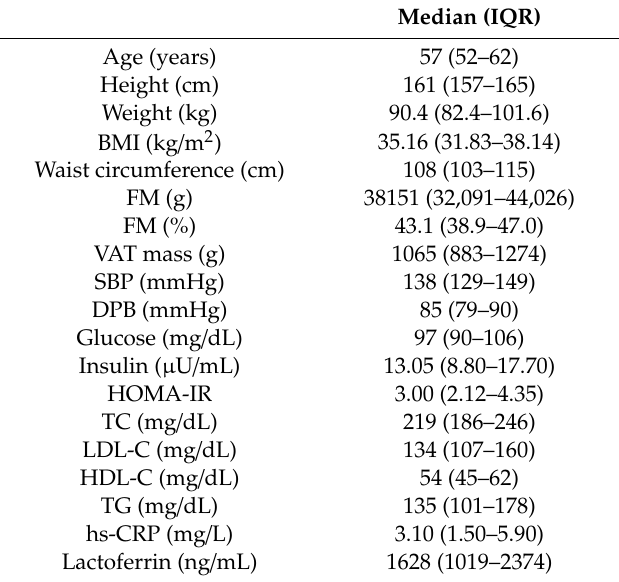
Table 1. Clinical characteristics of study population ( n =